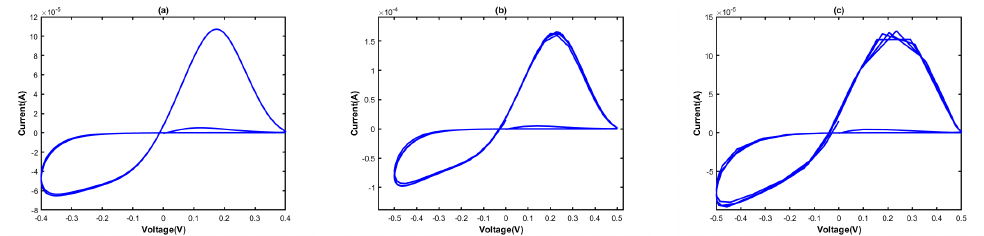
Figure 9. Voltage–current curves of various operating frequencies and capacitance, for 16 nm: